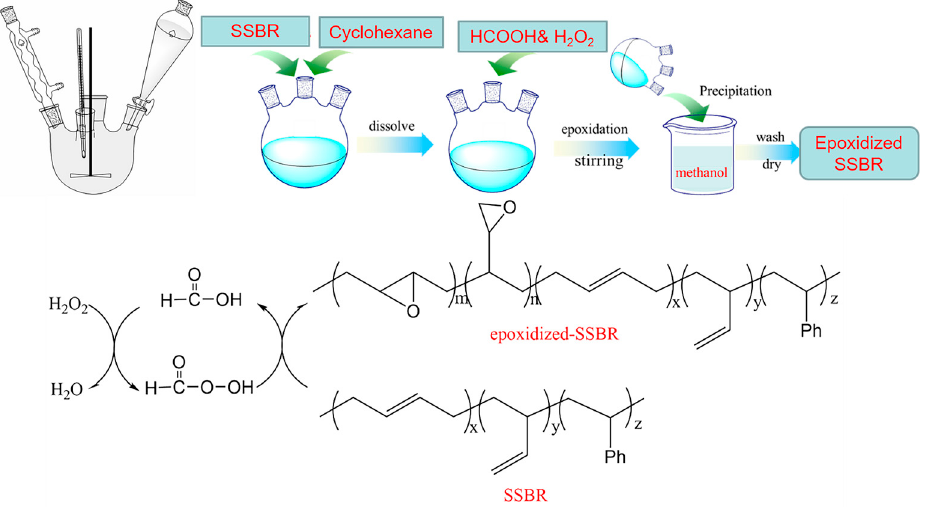
Figure 1. Reaction principle and flow chart.